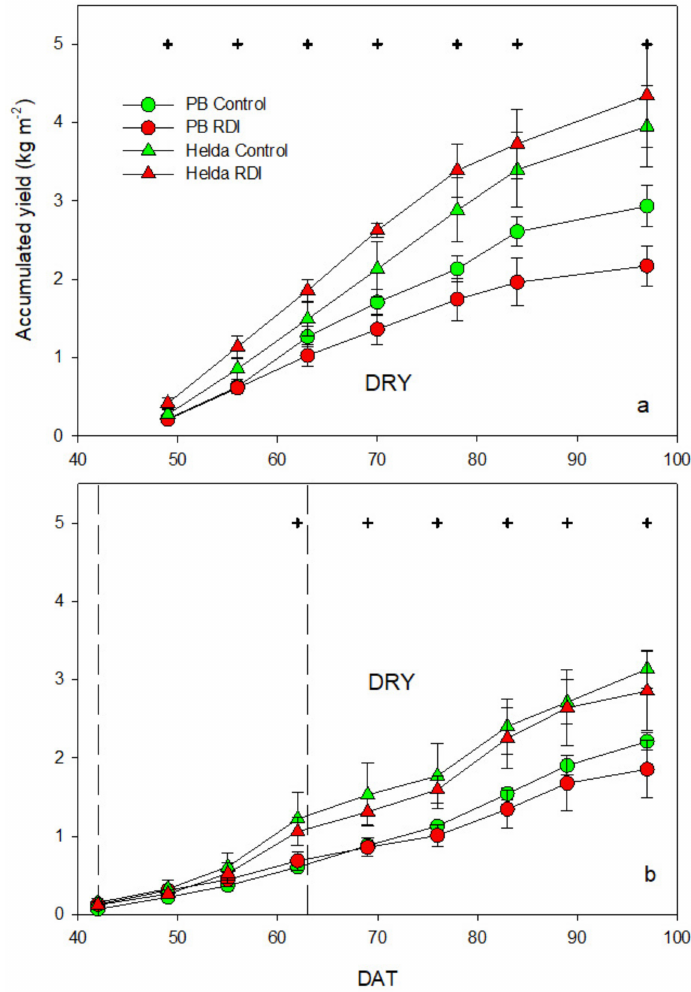
Figure 9. Pattern of accumulated yield during the 2020 ( a ) and 2021 ( b ) seasons. Each point is the average of four measurements. Vertical lines represent the standard error. Triangles, cv Helda (upside down, Control; upright, RDI); Circles, cv Perfeccion Blanca (red, Control; orange, RDI). Crosses indicate significant differences on that date ( p < 0.05). No important differences were found between irrigation treatments. The word “dry” indicates a period without